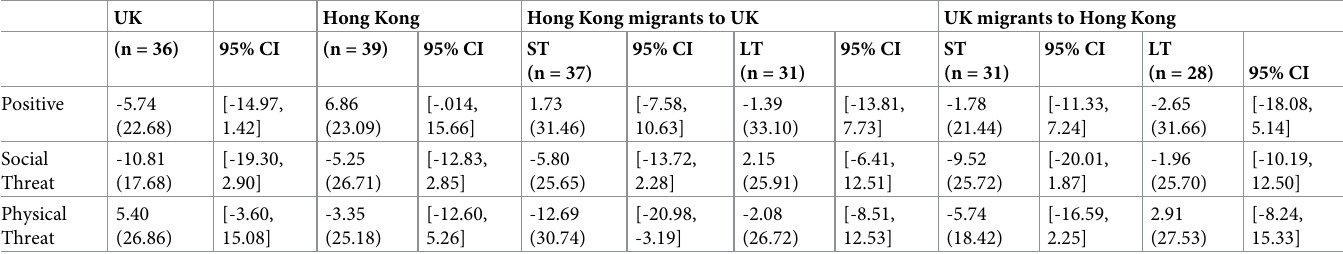
Table 5. Means (standard deviation) on attentional probe task (reaction time difference score: Mean neutral minus mean emotional trial, msec). UK Hong Kong Hong Kong migrants to UK UK migrants to Hong Kong (n = 36) 95% CI (n = 39) Positive -5.74